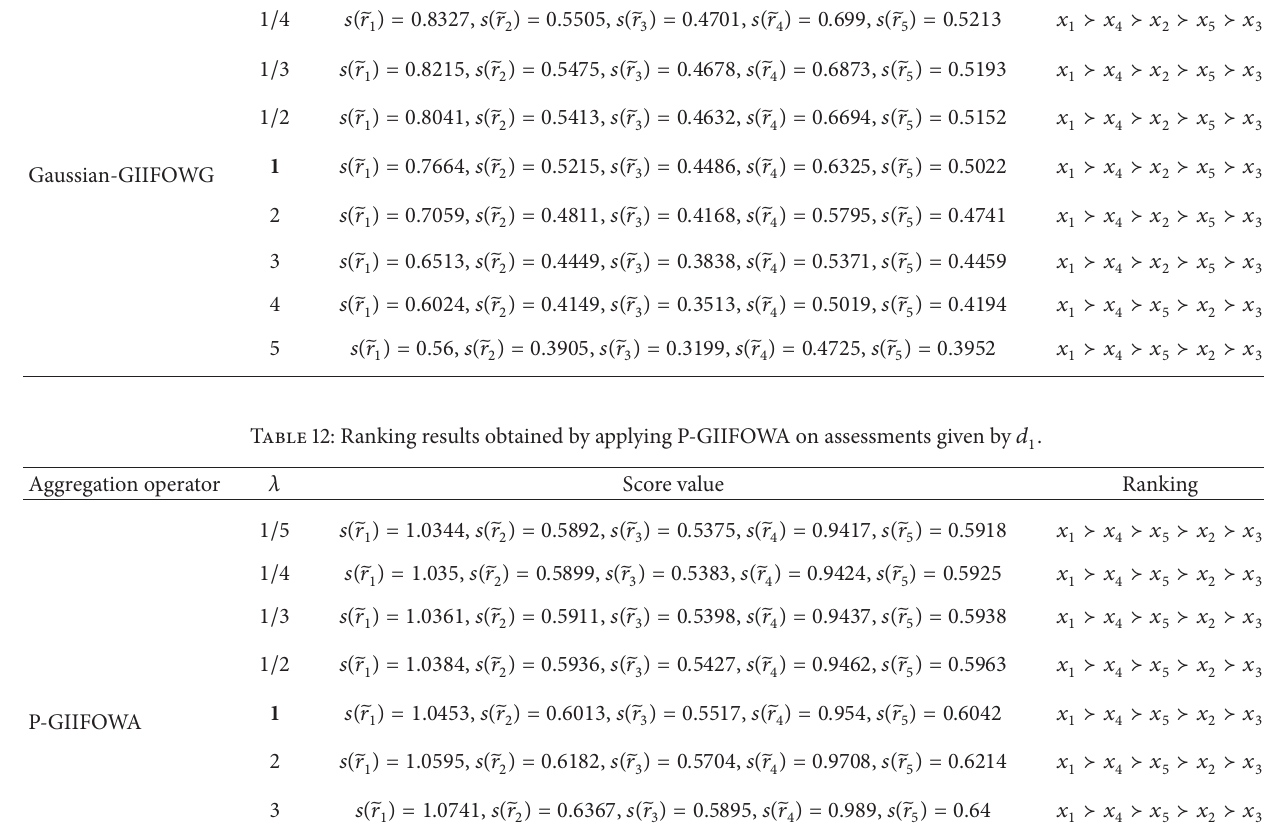
Table 11: Ranking results obtained by applying Gaussian-GIIFOWG on assessments given by 𝑑 1 . Aggregation operator 𝜆 Score value Ranking